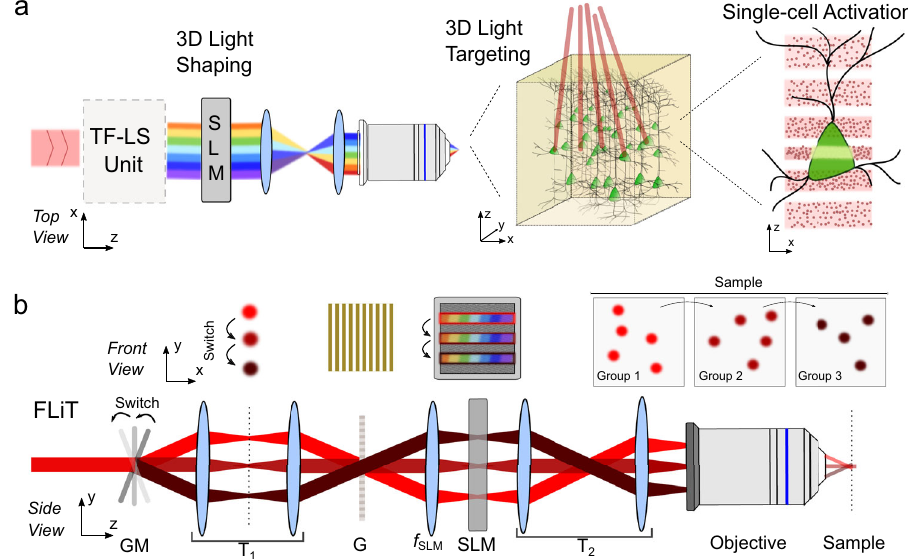
Fig.1|FLiTopticalscheme.a Generalopticalschemefortemporallyfocusedlight shaping. A temporally focused light-shaping architecture (TF-LS) allows (i) sculpt- ing light into speci fi c patterns and (ii) temporally focusing the photons to con fi ne photostimulation to a shallow axial region with cellular dimensions. A subsequent LC-SLM modulation allows multiplexing the sculpted light to multiple 3D sample locations (dots in the beam represent photons) . b Optical setup of FLiT. A pulsed collimated beam (red line) is re fl ected by a galvanometric mirror (GM) onto a diffracting grating (G) viaa 4f -telescope(T 1 ). Diffracted offthe grating, the beamis projected onto a liquid-crystal spatial light modulator (SLM) by a f SLM lens in the